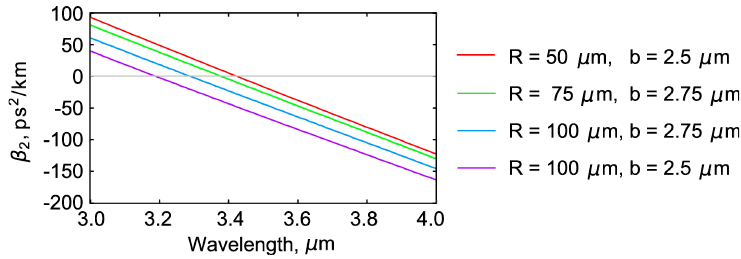
Figure 3. Dispersion as a function of wavelength.